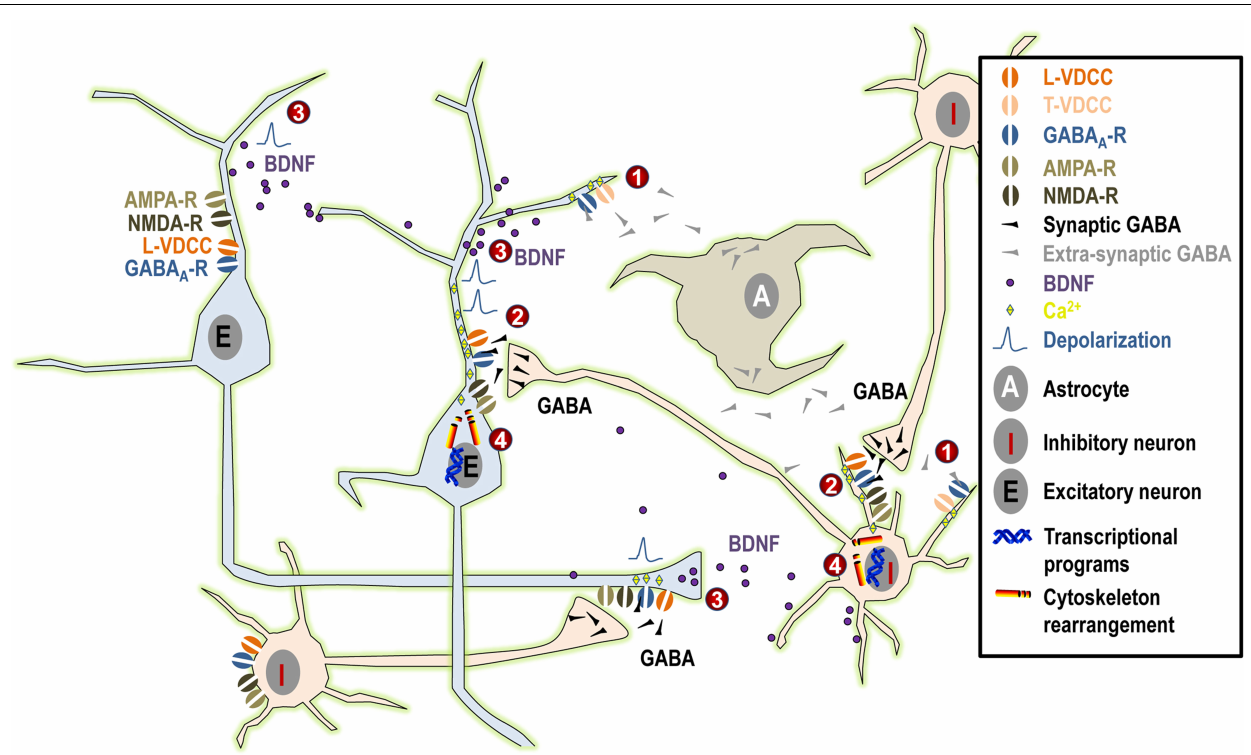
FIGURE 1 | Summary of the possible mechanisms linking GABA and neurite outgrowth. (1) Under normal physiological conditions, tonic GABAergic release from maturing neurons and/or from astrocytes induces small tonic depolarization that may be suffi cient to activate low-threshold T-type VDCCs and to promote the initial phase of neurite growth. (2) Subsequently, when synaptic GABA acts in synergy fi rst exclusively with NMDA receptors and at later stages both with AMPA and NMDA receptors, this will result in larger depolarization that may even reach fi ring threshold. Such larger depolarizing